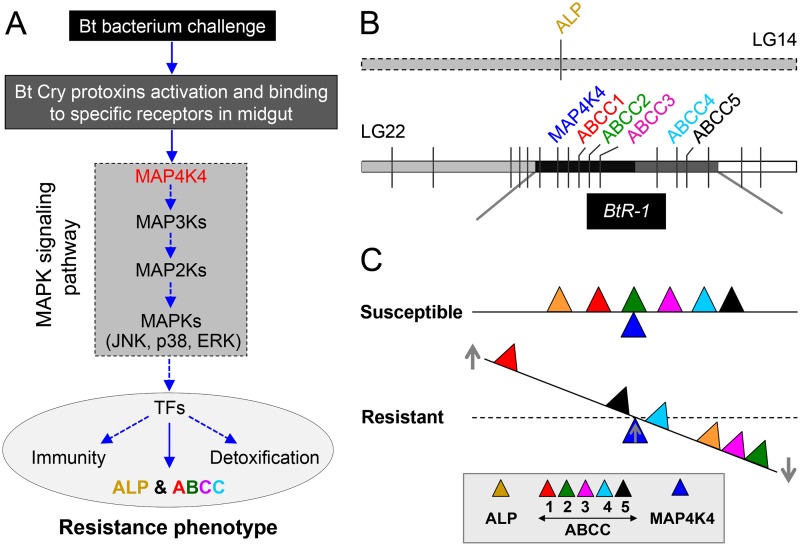
Schematic drawing depicting a novel Cry1Ac resistance mechanism in P. xylostella.(A) Cry protoxins produced by Bt bacterium are activated by midgut proteases and then bind to specific midgut receptors to form ionic pores leading to insect death. In resistant insects, over-activation of the MAPK signaling pathway (highlighted in the dashed box, MAP4K4 is an important upstream regulator) serves to alter the expression of different genes associated with the resistance phenotype, including receptor genes involved in Bt resistance probably through the regulation of diverse transcription factors (TFs). Blue arrows indicate recruitment, activation, or production. (B) Diagram of the physical location of the genes involved in Cry1Ac resistance in P. xylostella. ALP is located in the linkage group 14 and outside the BtR-1 resistance locus, whereas other genes are located within the BtR-1 locus in the linkage group 22 [26]. (C) MAP4K4-mediated interplay between ALP and ABCC genes among P. xylostella strains with different susceptibility to Cry1Ac toxins. Based on this study, we propose that MAP4K4 serves as a general switch modulating the differential expression of ALP and multiple ABCC genes in P. xylostella. While it is not linked to Cry1Ac resistance, up-regulation of ABCC1 in resistant P. xylostella larvae may represent potential compensatory effects that can help reduce fitness costs due to ABCC2 and ABCC3 down-regulation in resistant larvae. However, the data here does not strongly support the conclusion that expression levels of ABCC4 and ABCC5 are significantly regulated by MAP4K4 and changes in their expression obviously affect the development of Cry1Ac resistance. Up- and downward arrows in the figure represent the up- and down-regulation of genes, respectively, in Cry1Ac-resistant and susceptible P. xylostella strains. The distance remove from the fulcrum point reflects the qualitative magnitude of gene regulations.